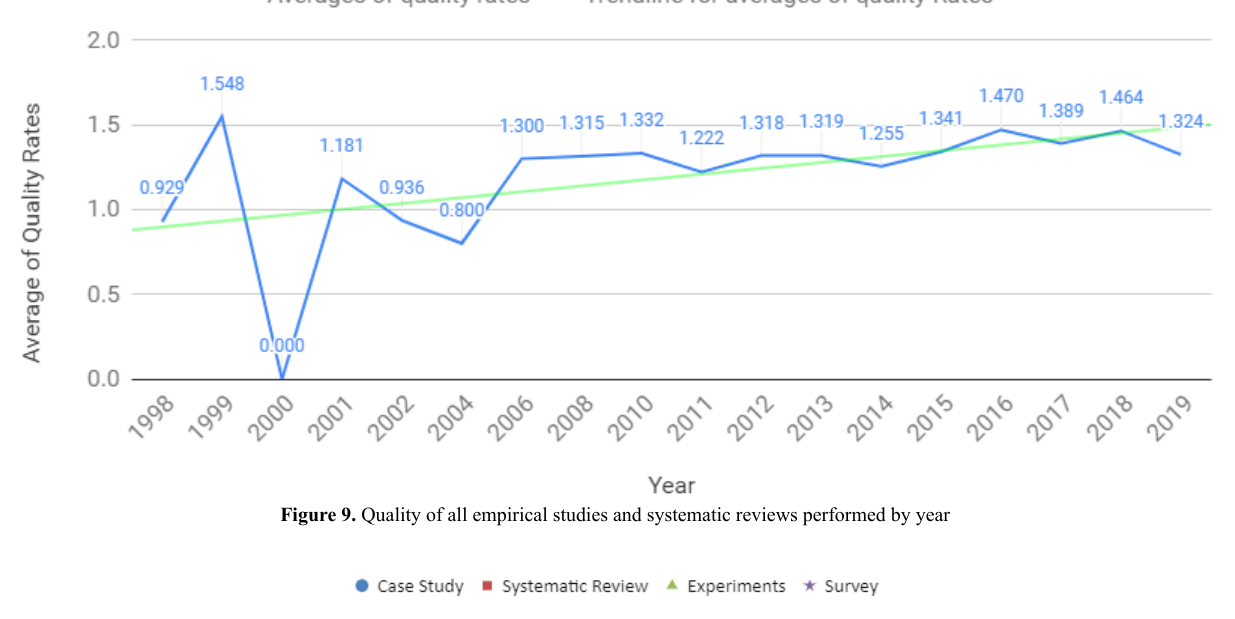
Figure 9. Quality of all empirical studies and systematic reviews performed by year